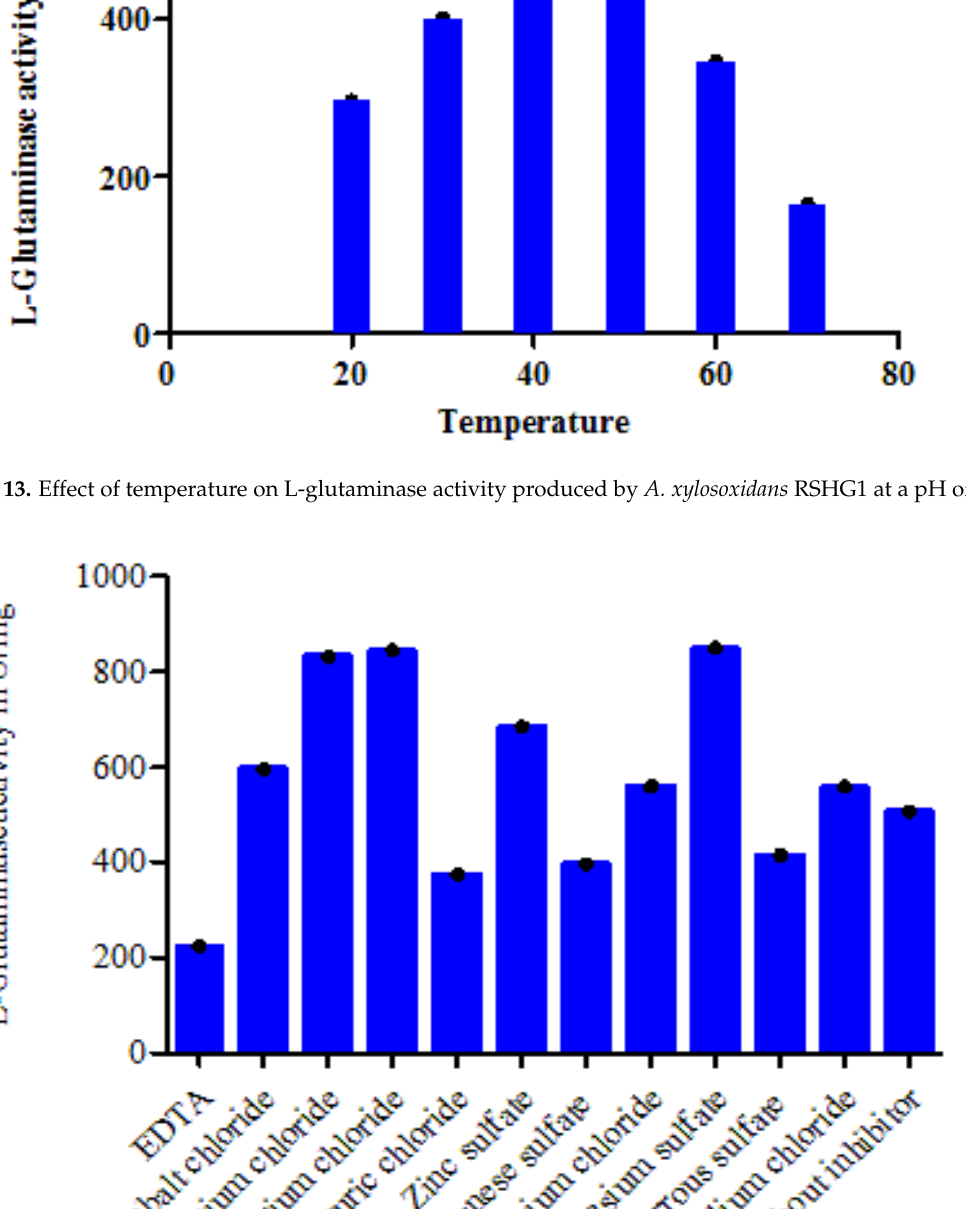
Figure 14. Effect of metal ions on L-glutaminase activity produced by A xylosoxidans RSHG1 at 40 °C, pH 7.